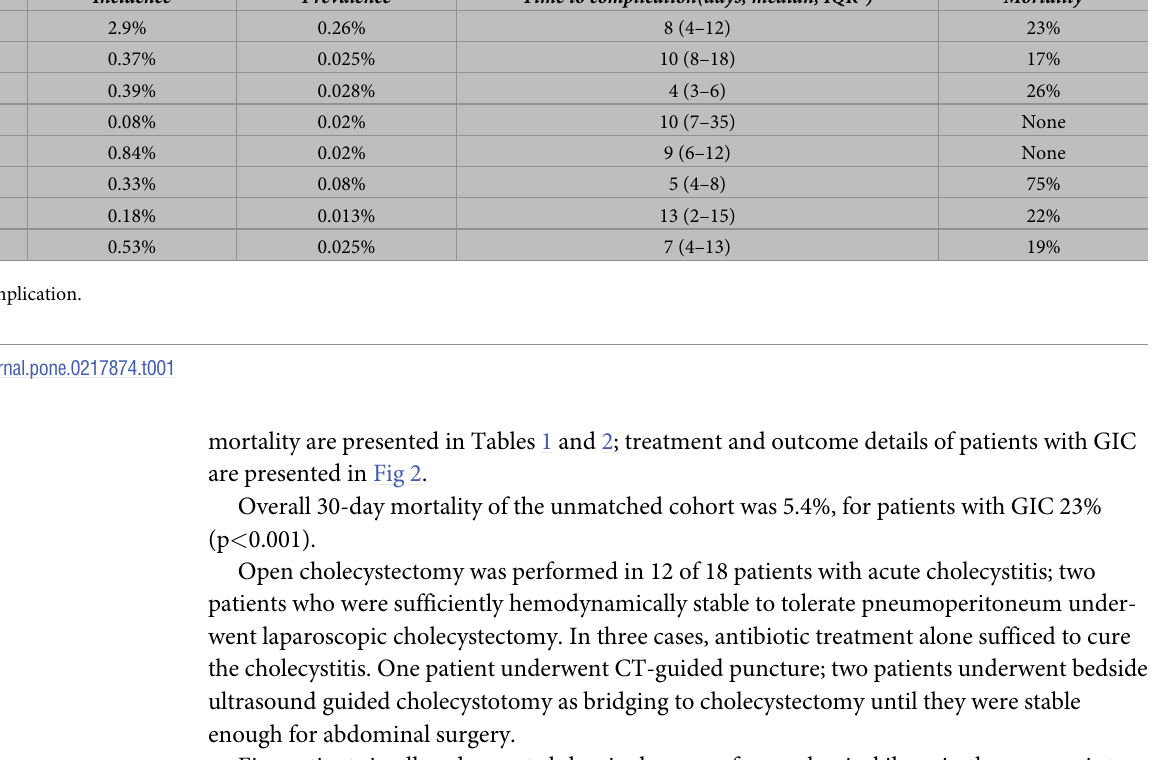
Table 1. Details about GIC.